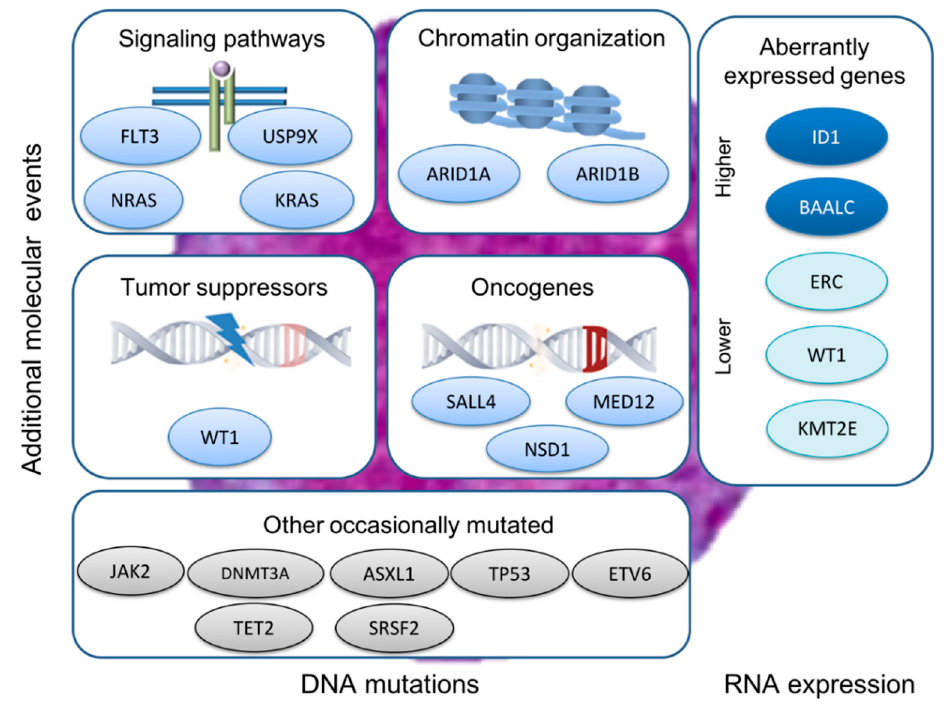
Figure 2. Acute promyelocytic leukemia (APL) molecular profile. APL and associated molecular events categorized by oncogenic mechanism. DNA mutations in genes involved with signaling pathways, chromatin organization, tumor suppressor and oncogenes, among others, and aberrantly expressed genes associated with PML-RARA rearrangement (in blue commonly mutated; in grey occasionally mutated).